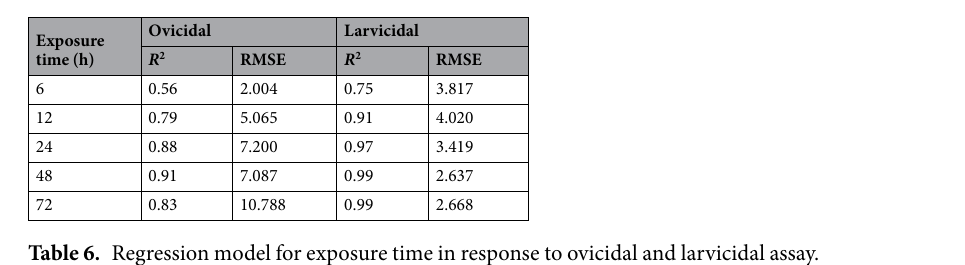
Table 6. Regression model for exposure time in response to ovicidal and larvicidal assay.